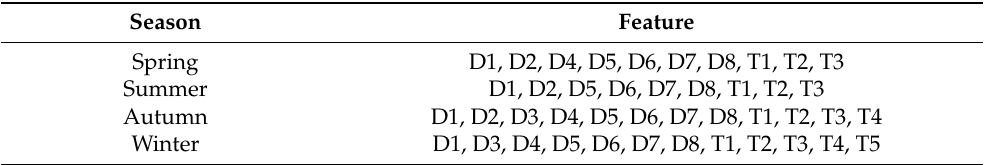
Table 4. The final feature selection result of four datasets.